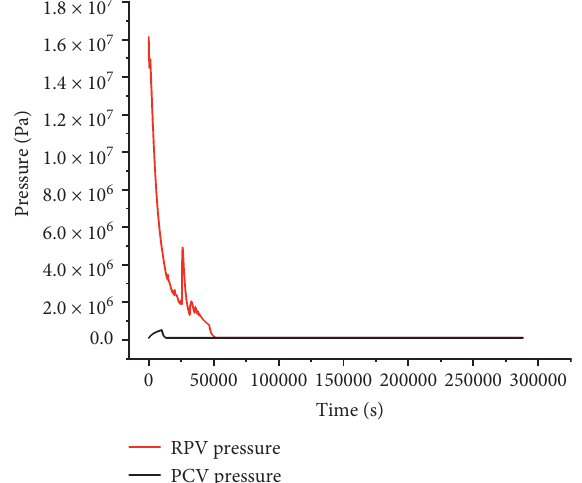
Figure 3: Pressure in PCV and